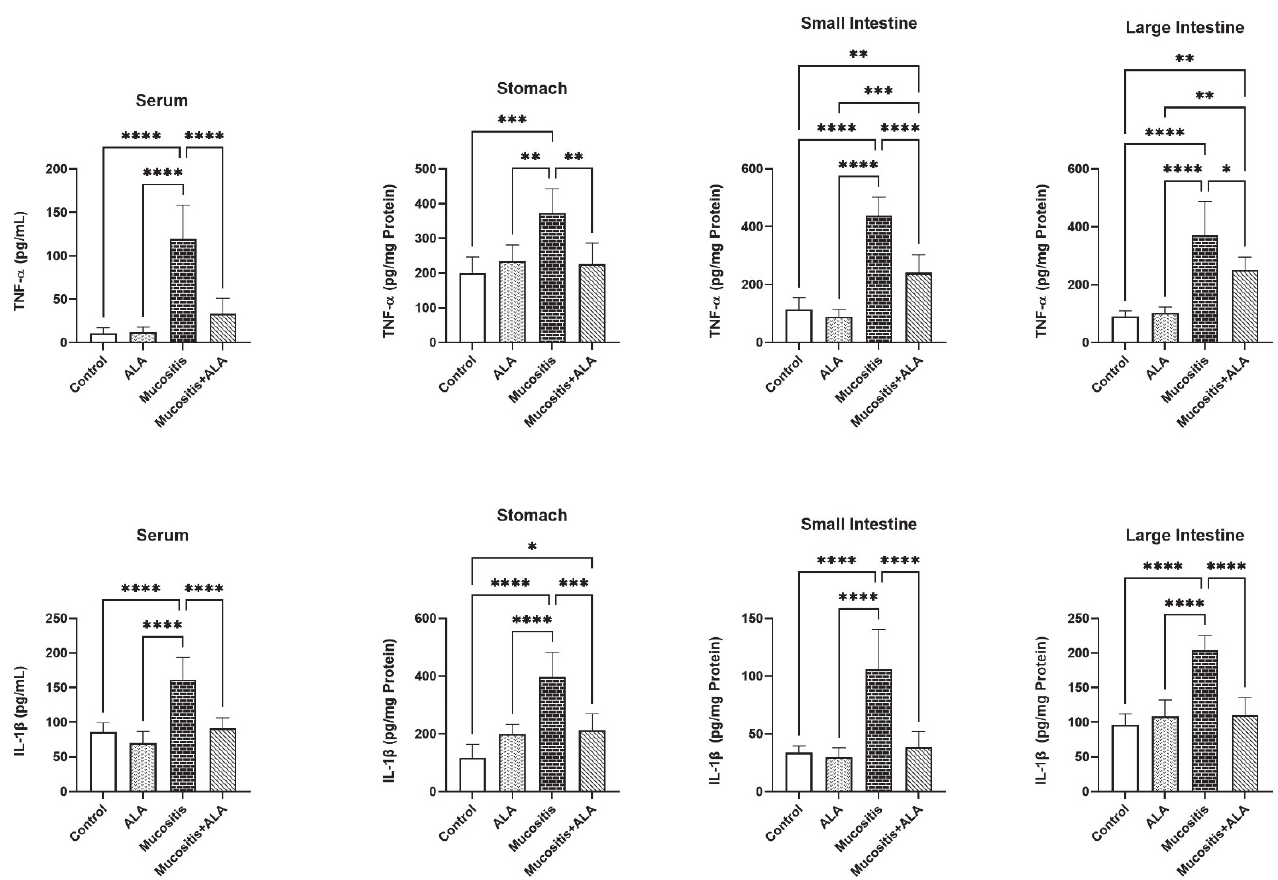
Figure 1. Comparisons of serum, stomach, small intestine, and large intestine concentrations of) TNF- α , IL-1 β in the Control, ALA, Mucositis and Mucositis + ALA groups. * p < 0.05, ** p < 0.01, and *** p < 0.001 and **** p < 0.0001.